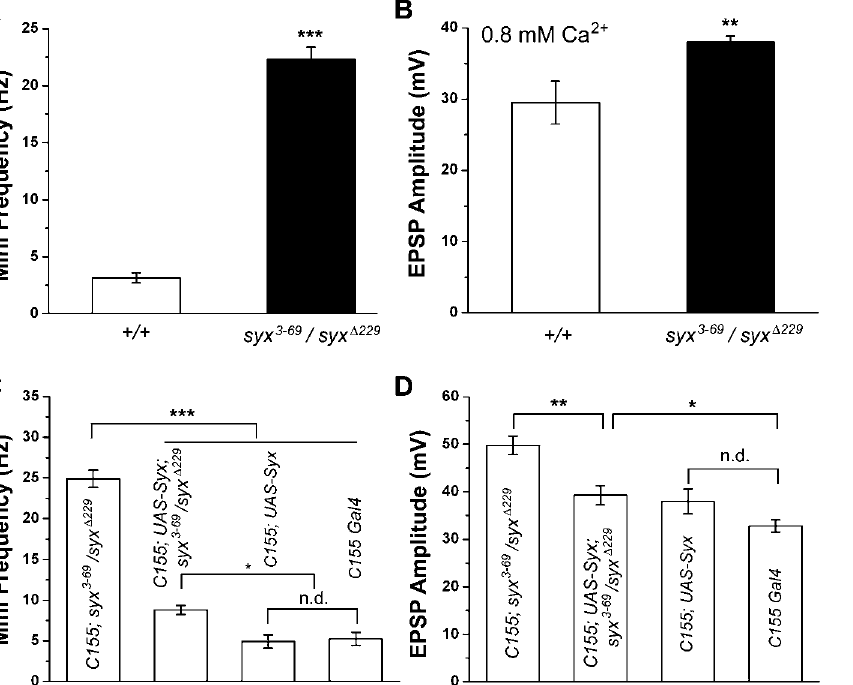
Figure 10. Genetic and Electrophysiological Evidence That Neuronal Overexpression of the Wild-Type Syntaxin 1A Specifically Rescues the syx 3–69 Mutant Phenotype (A and B) The increase in mini frequency and evoked EPSP amplitude persists in larvae carrying only one copy of the syx 3–69 mutant gene. This mutant fly (syx 3–69 / syx D 229 ) is generated by placing one mutant gene in trans to the null mutation (syx D 229 ) in the syntaxin locus. These electrophysiological defects are nearly identical to those found in the syx 3–69 / syx 3–69 homozygote, but different in mini frequencies from the syx 3–69 / þ heterozygote. These results demonstrate that the mutant phenotype is specifically caused by the syx 3–69 mutation. **, p , 0.01; ***, p , 0.001. (C and D) Neuronal overexpression rescues the physiological defects observed in syx 3–69 mutants. In C155 Gal4 background, the syx 3–69 / syx D 229 mutant only expresses one copy of the T254I mutant protein. Under such circumstances, the C155 Gal4; syx 3–69 / syx D 229 larvae display an extraordinarily high frequency of minis and enhanced amplitude of EPSPs. Neuronal overexpression of the wild-type syntaxin 1A (UAS-Syx driven by C155 Gal4) in the syx 3–69 / syx D 229 mutant background dramatically reduces mini frequency to a level slightly higher than that in the wild type (i.e., C155 Gal4; UAS-Syx or C155 Gal4 flies) (C). The EPSP amplitude is also similarly reduced to the wild-type level (D). Importantly, overexpression of the wild-type syntaxin 1A in the wild-type background (i.e., C155 Gal4; UAS-Syx) has little effect on both the mini frequency and evoked EPSP amplitude compared to the C155 Gal4 flies. Thus, the rescuing effect on vesicle fusion by the wild-type syntaxin 1A is specific to the T254I mutant syntaxin 1A in the syx 3–69 mutant. *, p , 0.05; **, p , 0.01; ***, p ,